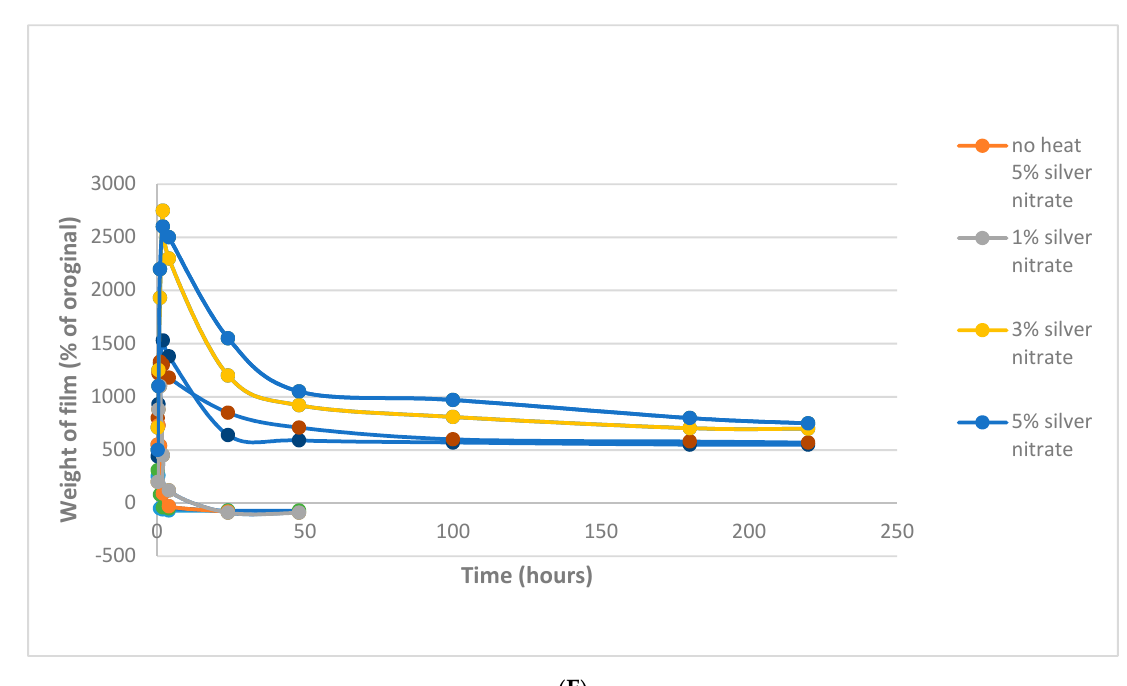
Figure 5. ( A ) Degradation of 100 μ m PVA/silver films heated at 80 °C for 90 m and then immersed in water; ( B ) degradation of 200 μ m PVA/silver films heated at 80 °C for 90 m and then immersed in water; ( C ) degradation of 100 μ m PVA films heated at 110 °C for 90 m and then immersed in water; ( D ) degradation of 200 μ m PVA/silver films heated at 110 °C for 90 m and then immersed in water; ( E ) degradation of 100 μ m PVA films heated at 140 °C for 90 m and then immersed in water; ( F ) degradation of 200 μ m PVA films heated at 140 °C for 90 m and then immersed in water.